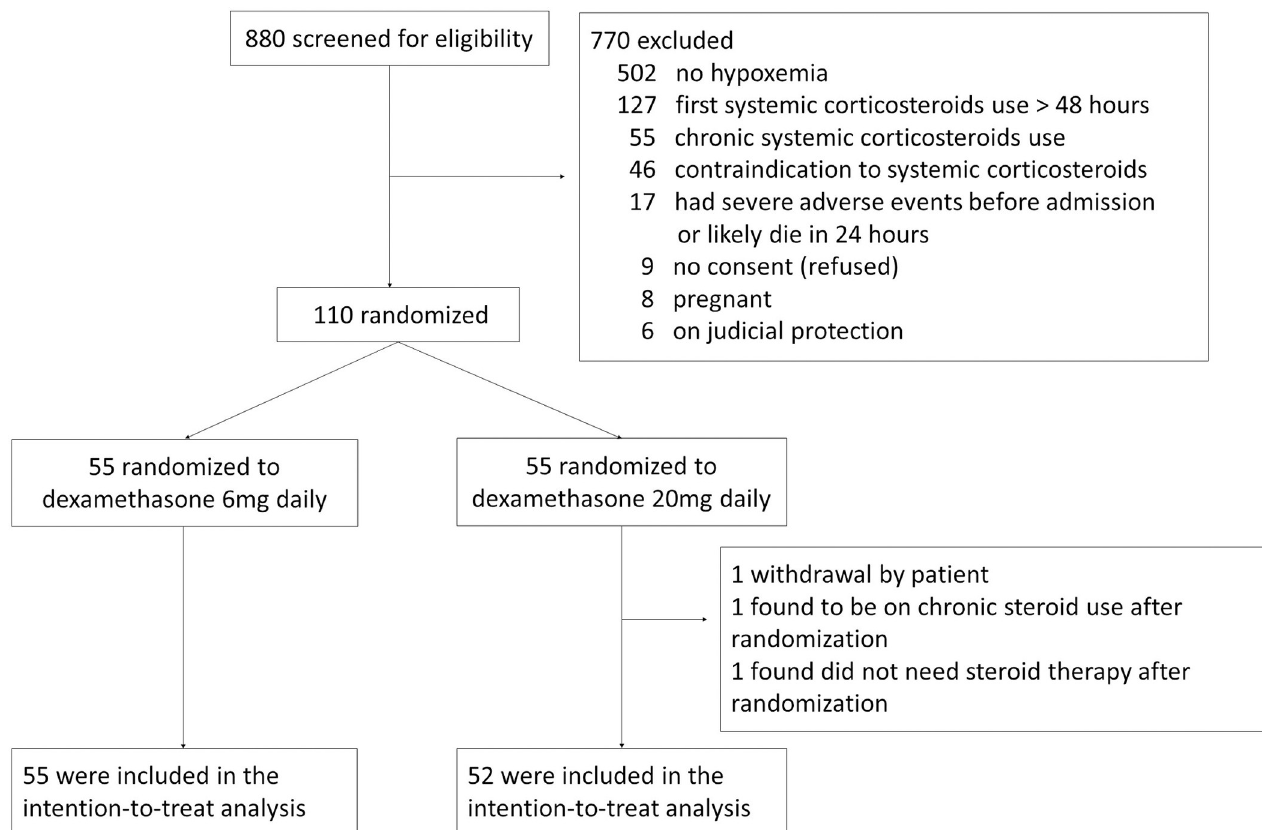
Fig 1. Consolidated standards of reporting trials diagram for flow of study